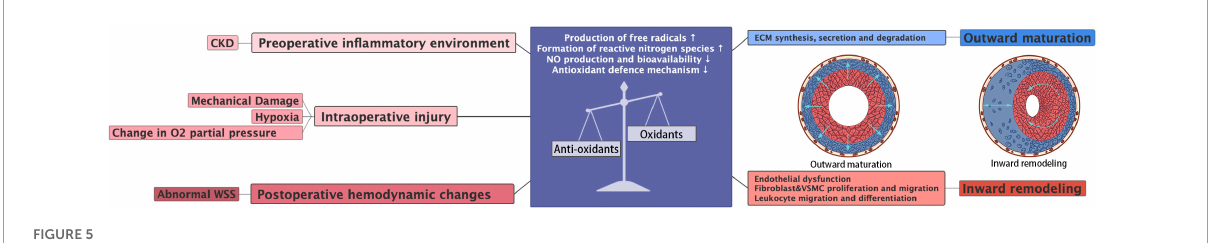
FIGURE5 Source and consequences of imbalance oxidative stress in